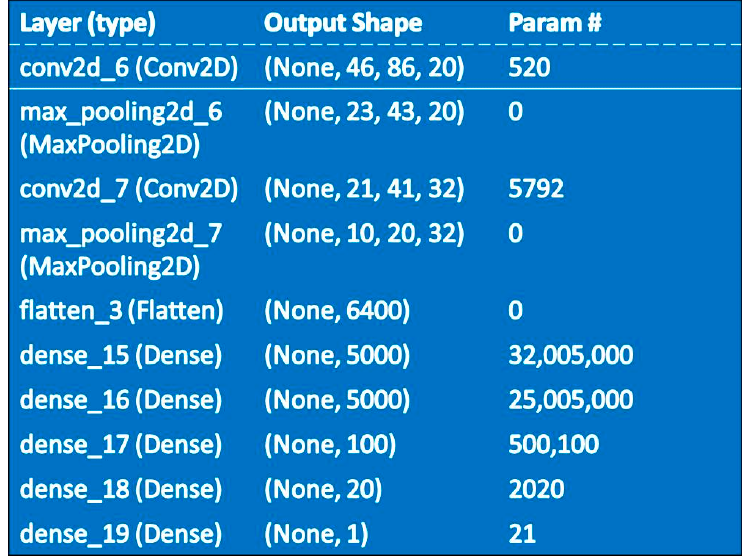
Figure 12. ( A ) Overlay of spectral data associated with four example target materials. ( B ) Segregation of the spectra.